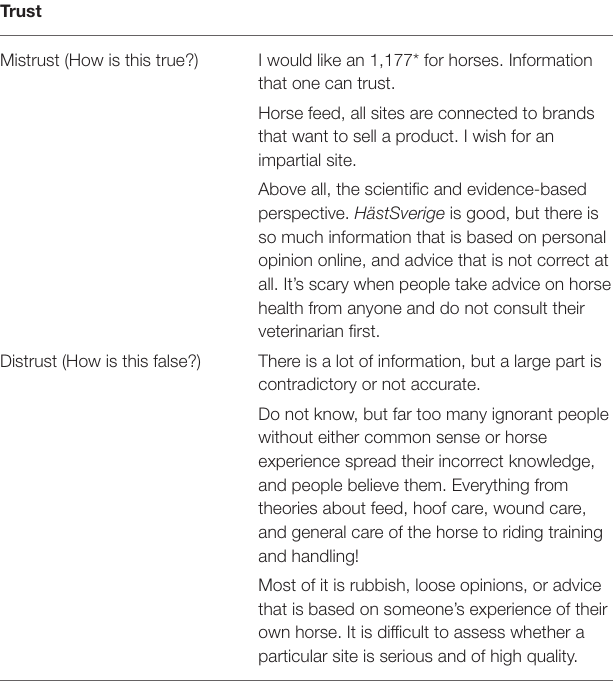
TABLE 5 | The theme trust. Trust Mistrust (How is this